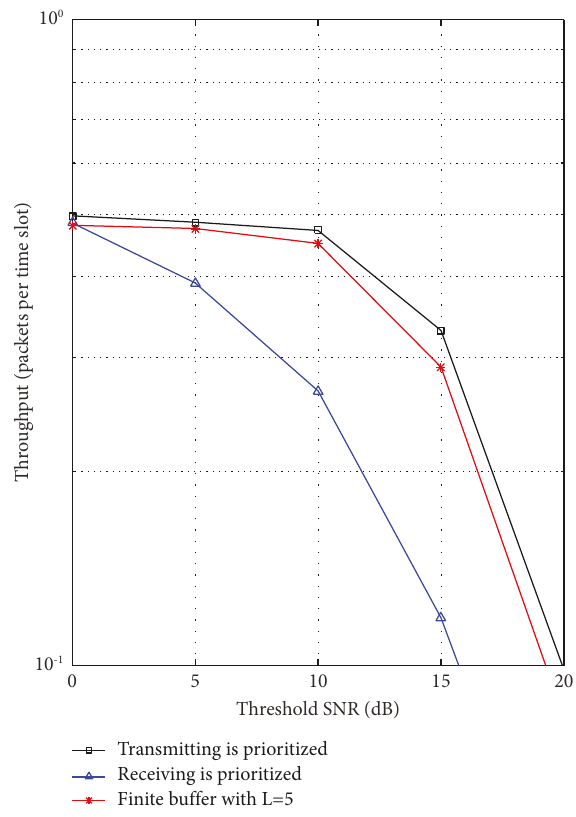
Figure 6: Outage probability comparison between the available solutions and the proposed